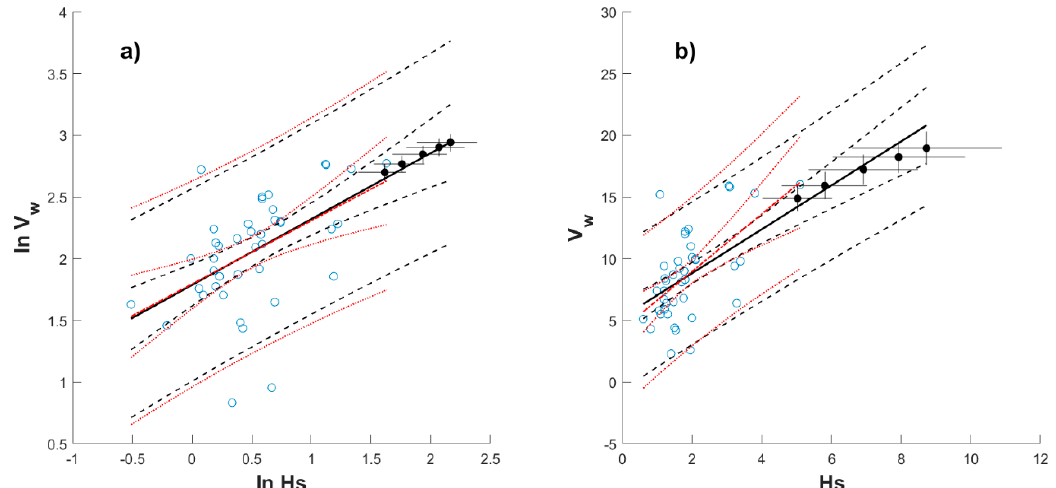
Figure A5. Regression lines and confidence intervals including (solid and dashed lines, respectively) and excluding (dashed–dotted and dotted lines, respectively) T -yr values for June; ( a ) and ( b ) for logarithmic space and linear space, respectively. Filled circles represent T -yr values with embedded perpendicular lines indicating confidence intervals from GEV models.